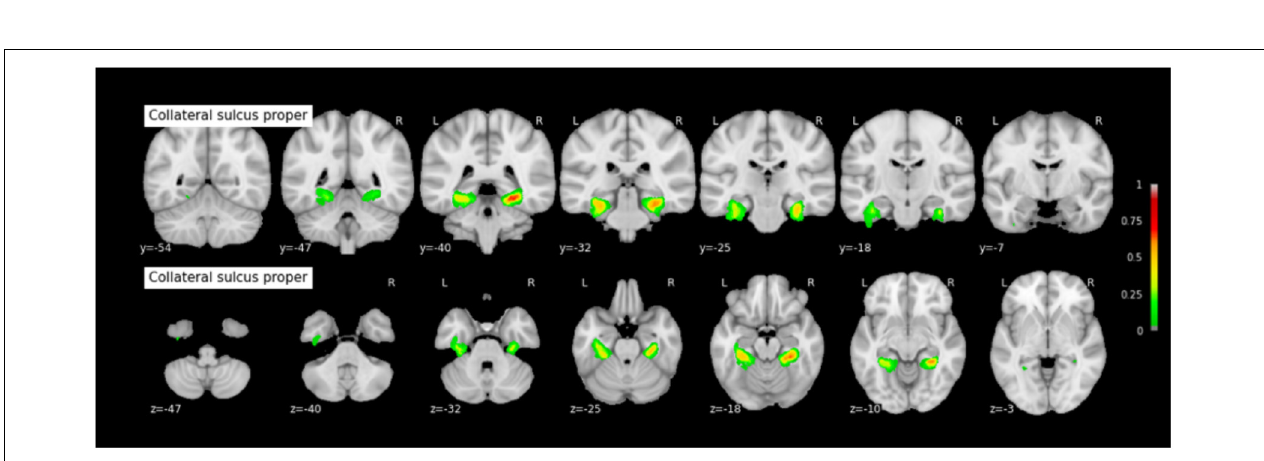
FIGURE 5 | Probabilistic map of the collateral sulcus proper (CS proper). The maps are normalized into the MNI stereotaxic space. Coordinates are indicated on each slice.